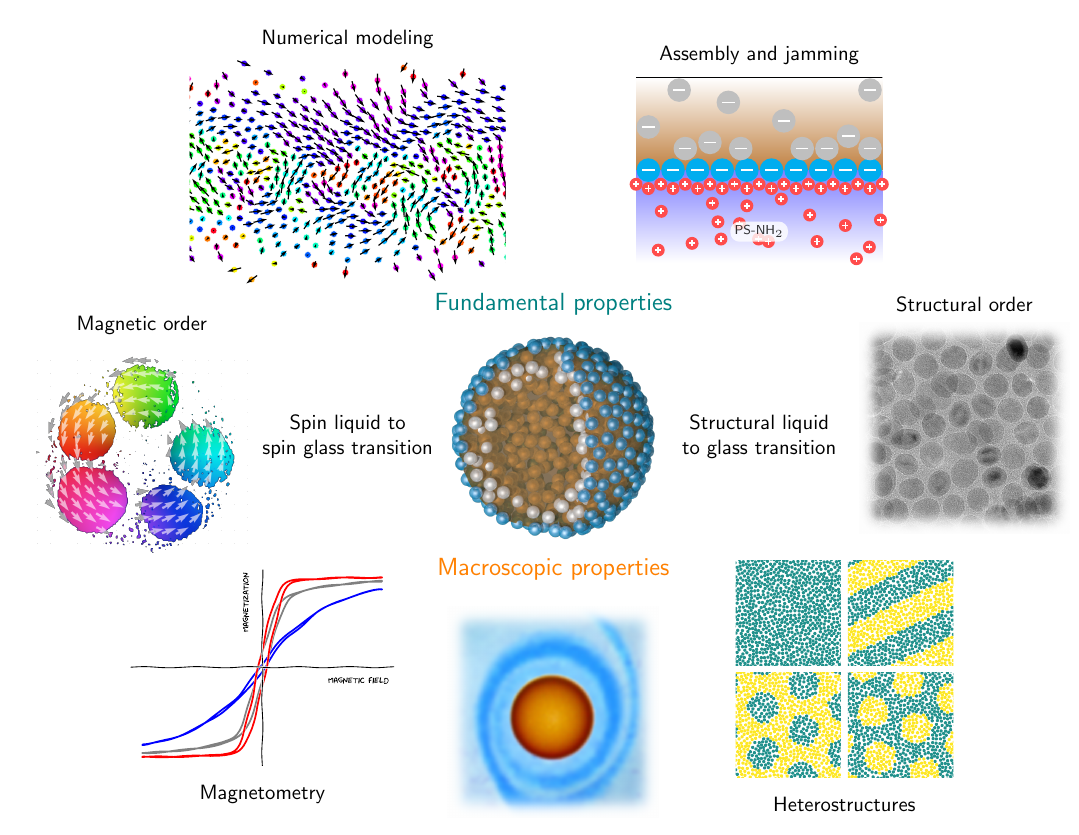
Figure 6. Scientific perspective on ferromagnetic liquids concerning the correlation between structural and magnetic short-range order, and the link between fundamental and macroscopic